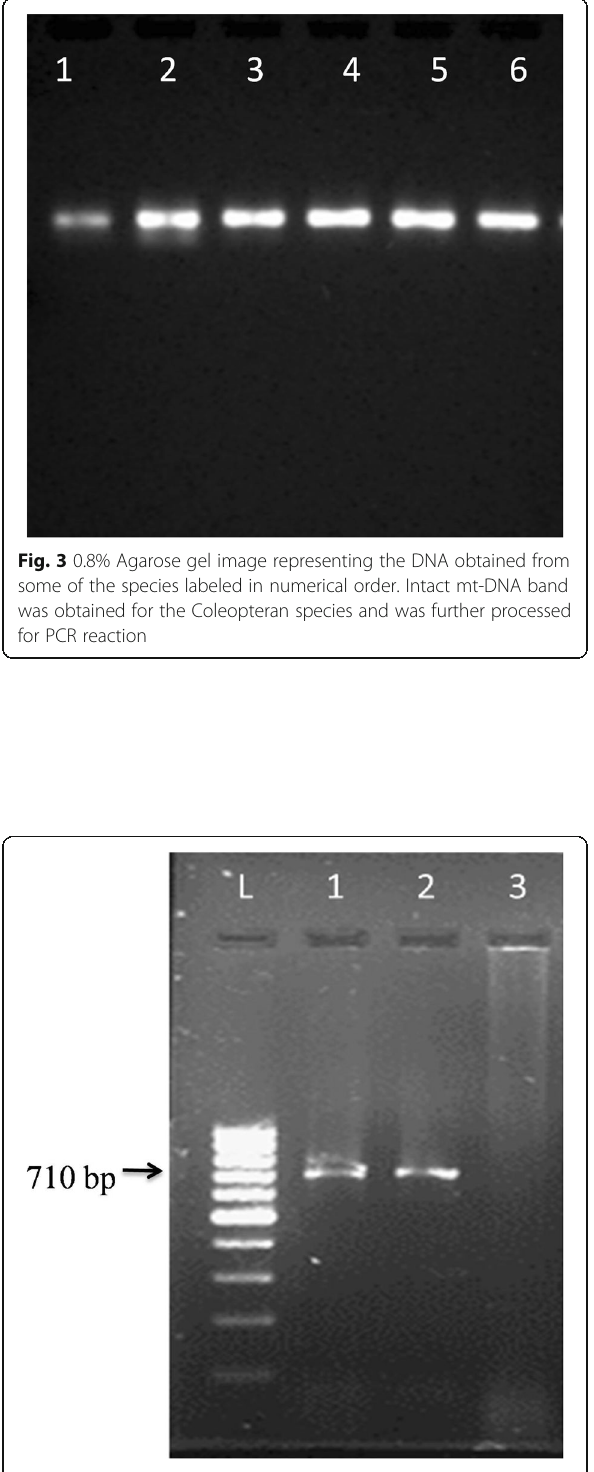
Fig. 4 2% Agarose gel image of amplified DNA obtained after the PCR done in some of the samples. (L) on the first well indicates the 100-bp ladder used to check the amplification of PCR product. The 1 and 2 represent the intact amplified COI gene of mt-DNA of two species, and the third lane was of negative control